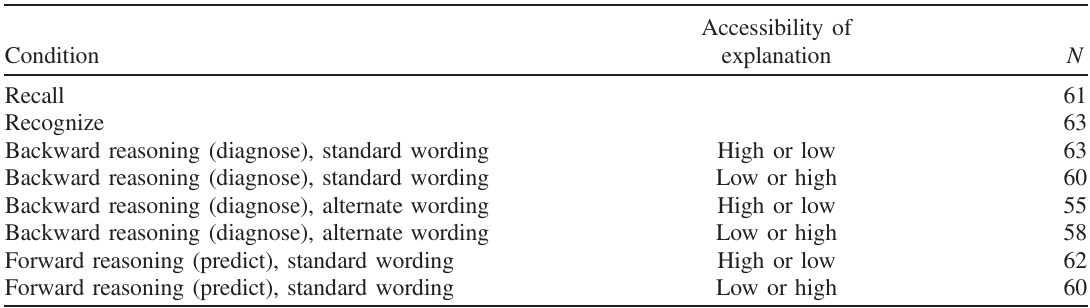
TABLE VII. Experiment 3 conditions.